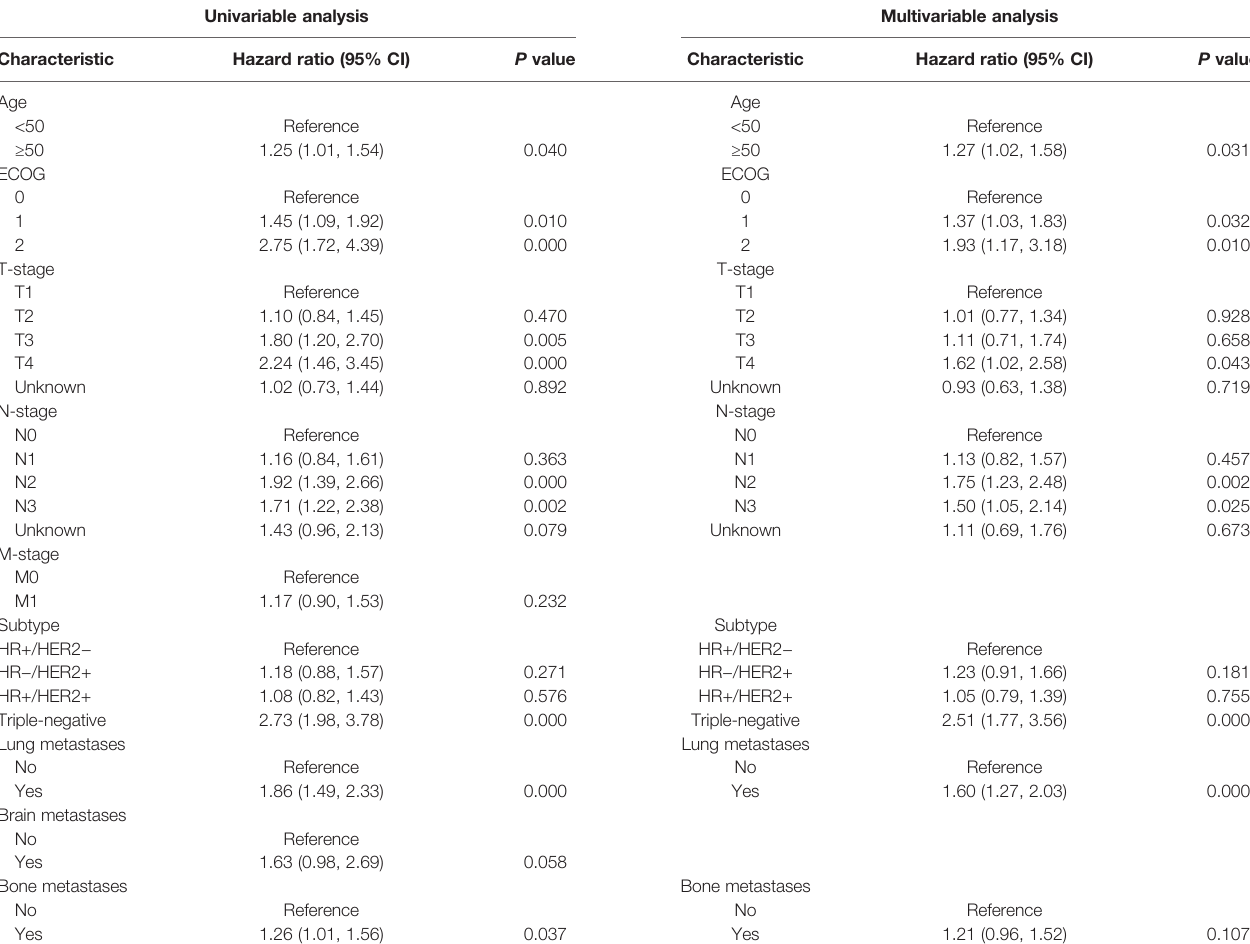
TABLE 4 | Univariable and multivariable cox regression analyses of overall survival in BCLM